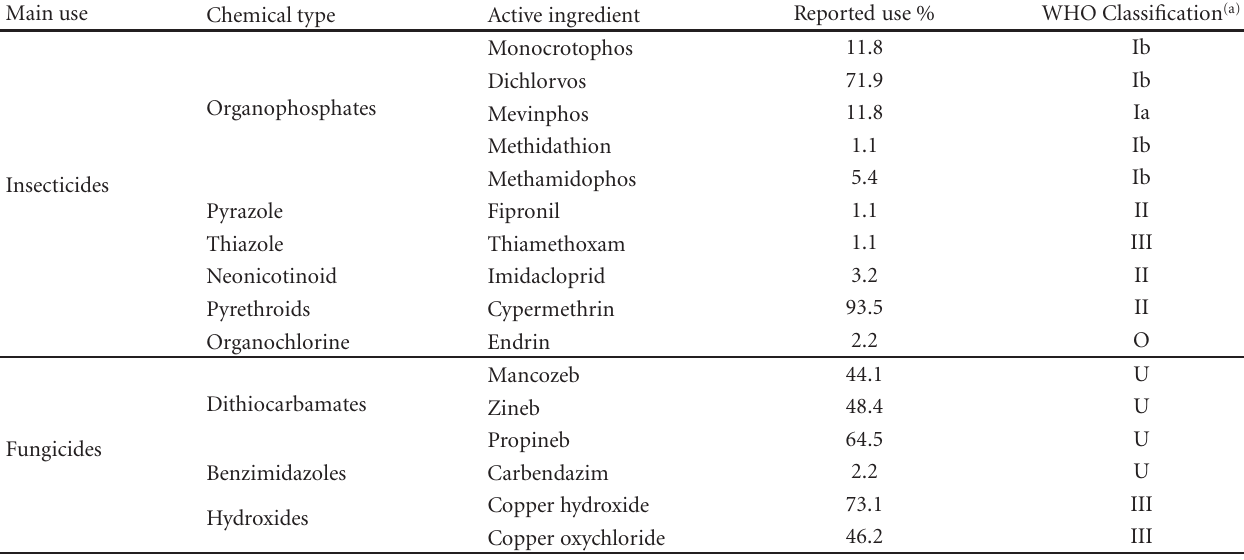
Table 1: Pesticides used by 93 households in Boeung Cheung Ek Lake, Phnom Penh, Cambodia.